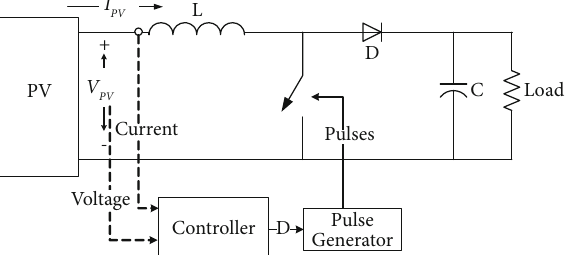
Figure 3: The current path in zero radiation condition of a panel.